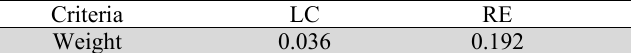
Criteria weights for Example 1